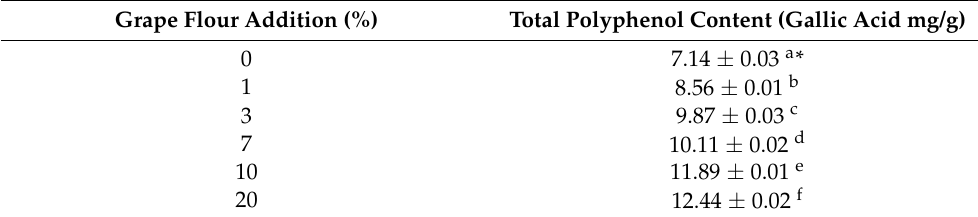
Table 2. Total polyphenol content in the samples of vegetarian sausages. Grape Flour Addition (%)